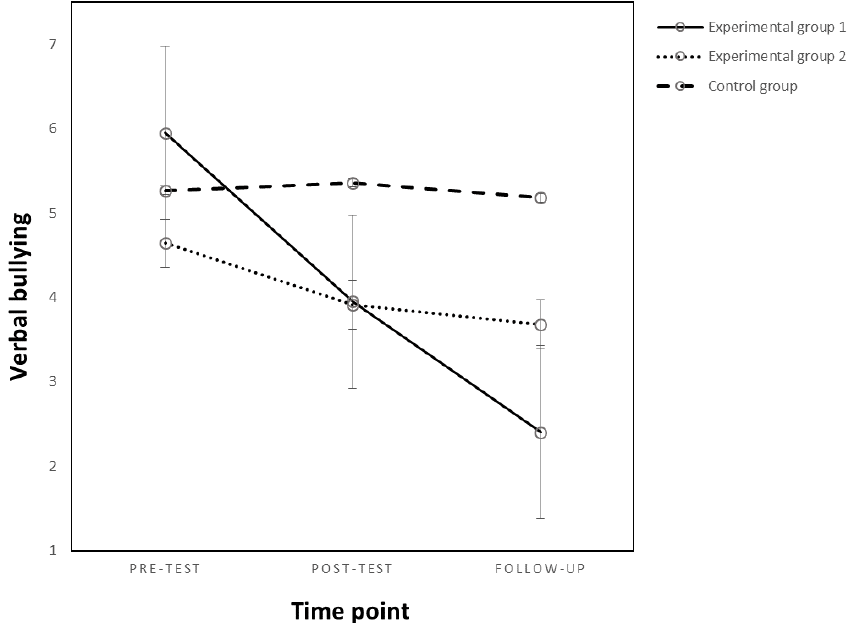
Figure 2. Changes in verbal bullying as an effect of the experimental condition and time